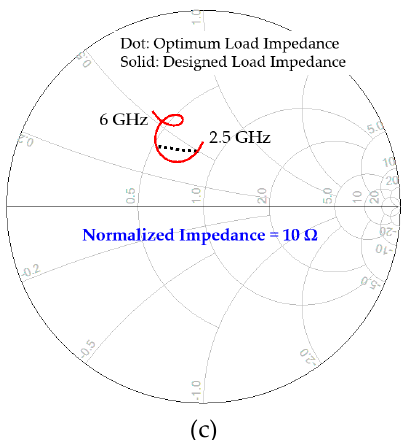
Figure 7. Schematic circuit diagram of the designed power amplifier ( a ), input/output matching impedance traces at 4 GHz ( b ), and the designed load impedance trace seen from the drain of the transistor ( c ).